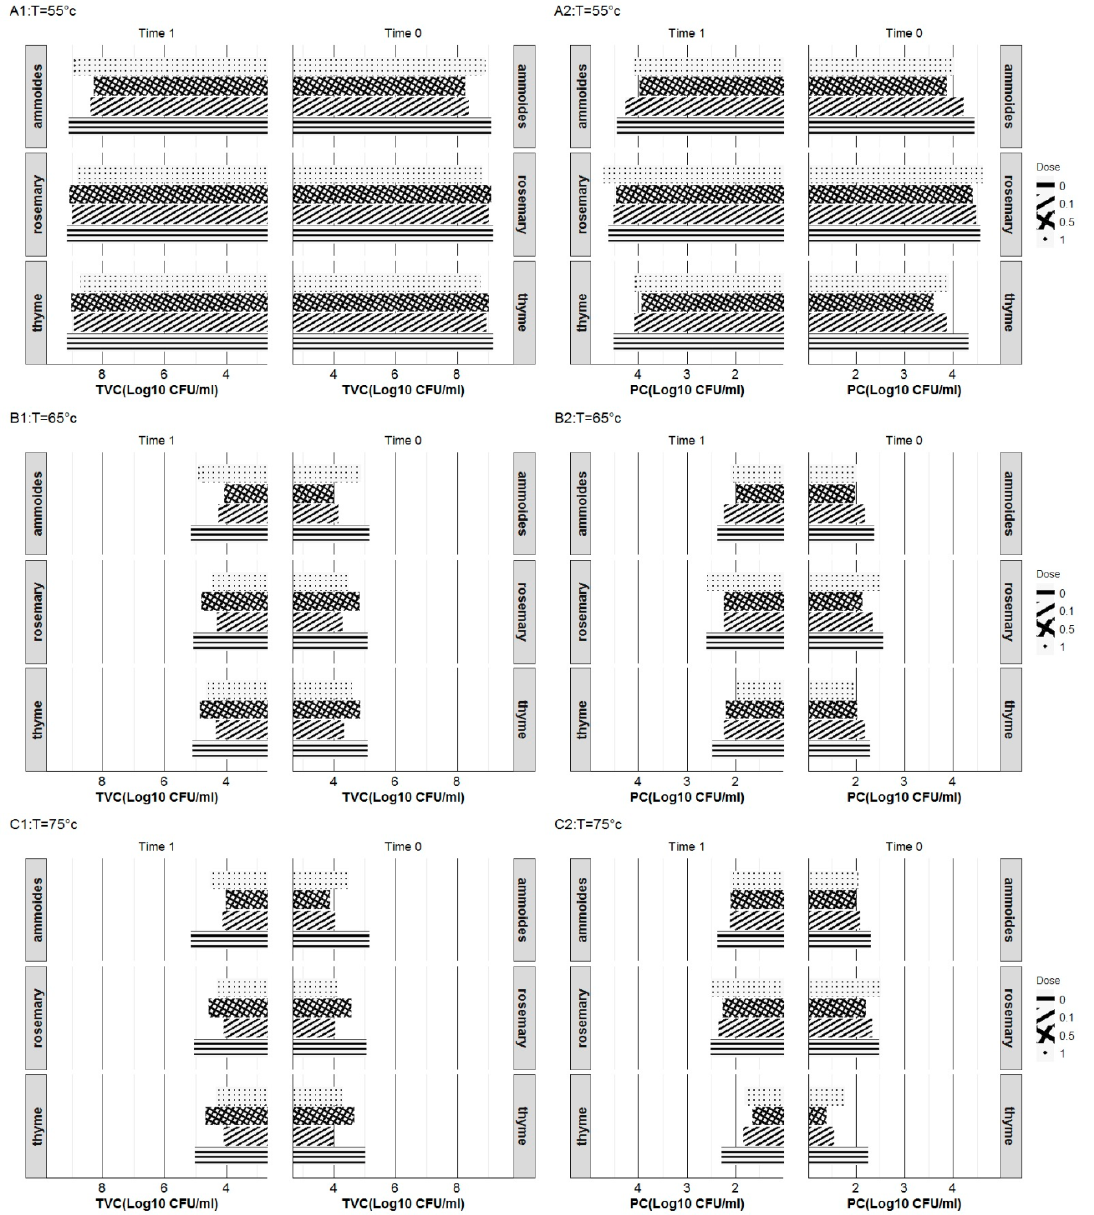
Figure 1. Total viable count and psychrotrophic bacteria count (TVC (1) and PC (2)) of thyme, rosemaryand ammoidesextractssupplemented milk sample, heat-treated at 55 °C (A1-2), 65 °C (B1-2), and 75 °C (C1-2). Aqueous extracts were added to milk at different levels (0, 0.1, 0.5, and 1 mg/mL).The bacterial countingwas carried out directly after heat treatment (Time 1) and after 12 h of refrigerated storage at 6 °C (Time 2).